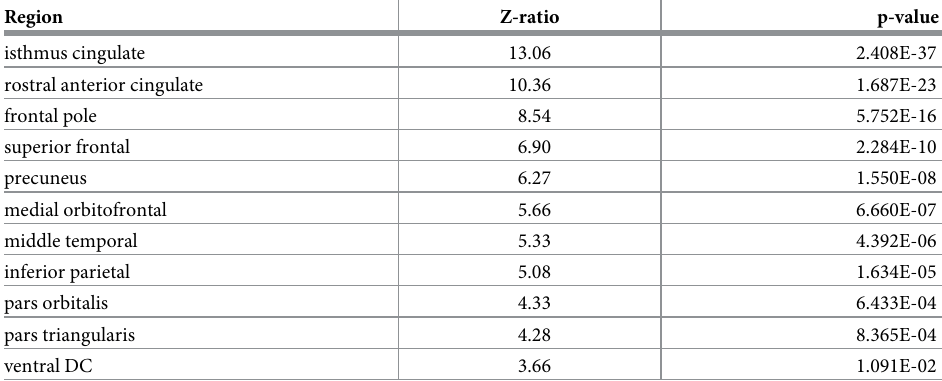
Table 6. Cortical and subcortical areas showing reliable co-activity with IC5 (correlated with default mode net- work) relative to the mean co-activity value of all other areas. p-values corrected for multiple comparisons using Bonferroni correction.